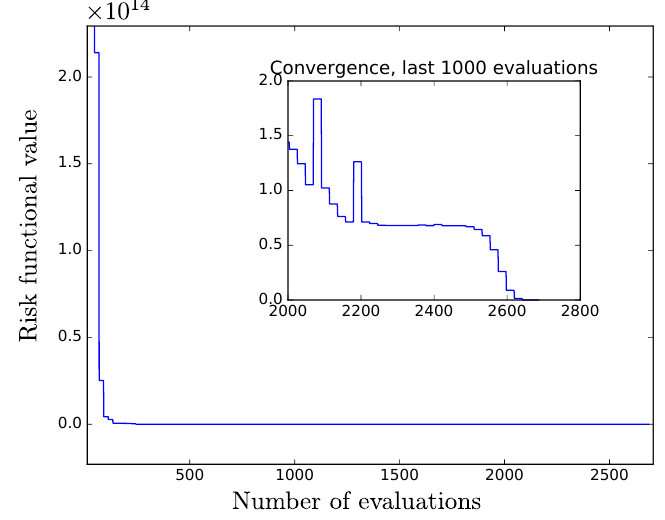
Figure 2. Convergence of the BH algorithm for Example 2.